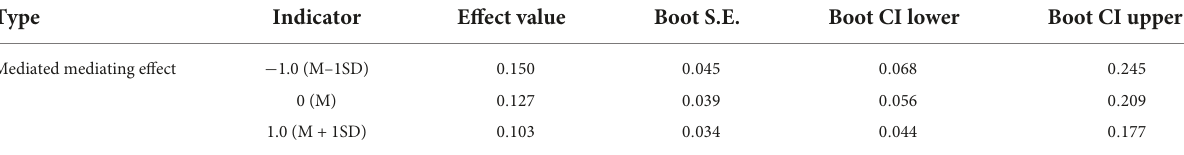
TABLE 3 Mediating effects at different levels of parental support ( N = 401).